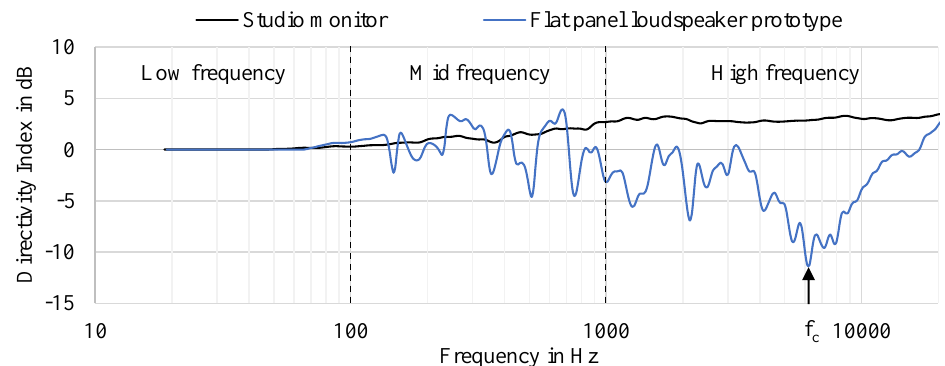
Figure 2. Directivity index calculated as the difference in the LW ( ± 30 ◦ ) and the front hemisphere (FH, ± 90 ◦ ) for the studio monitor and flat panel